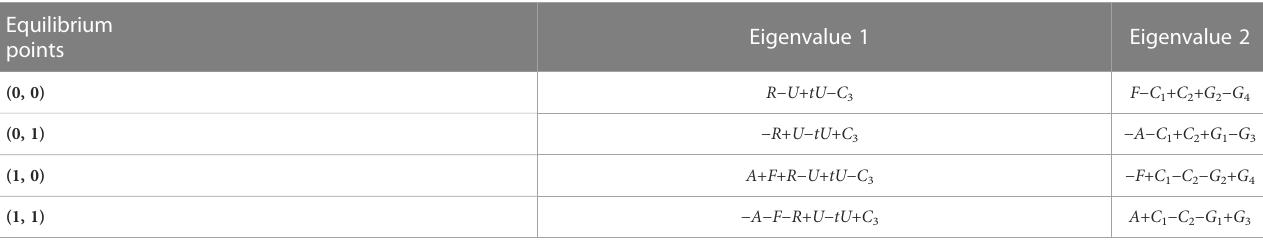
TABLE 5 Eigenvalues of Jacobian matrix J ( fi rst stage). Equilibrium